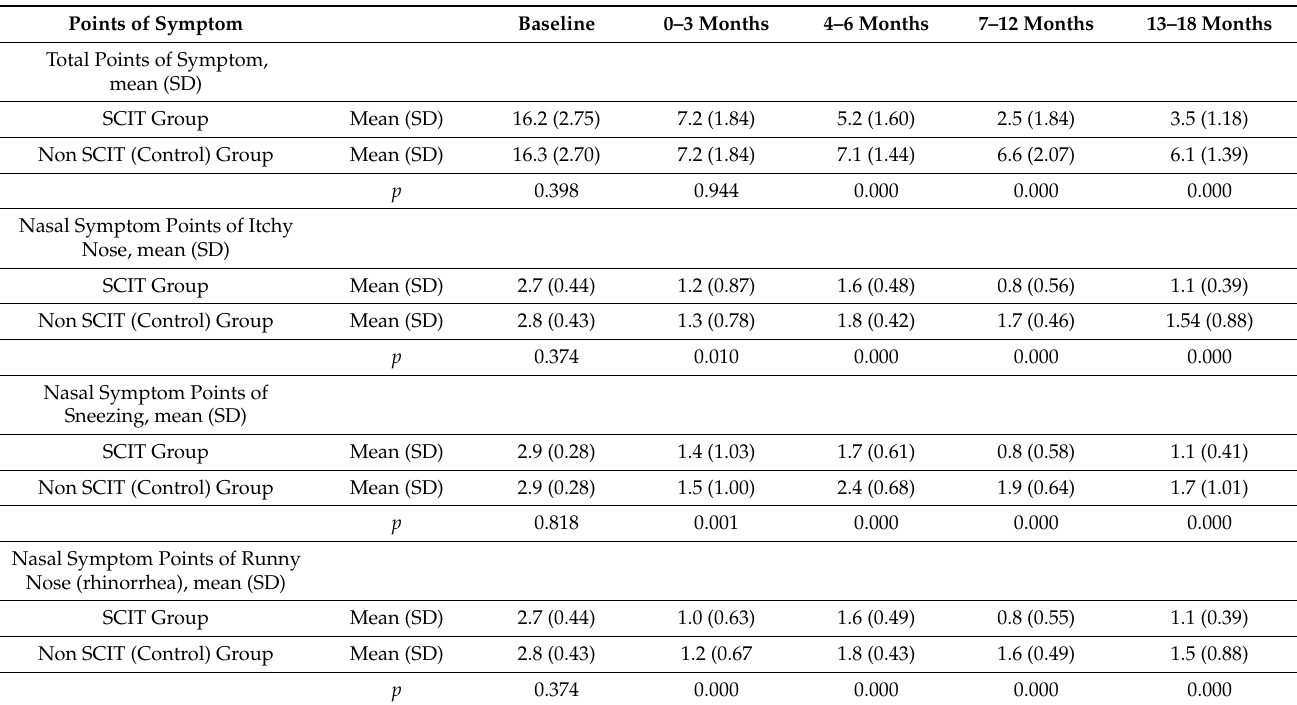
Table 3. The effect of SCIT on points of symptoms (Nasal, Eye, and Lung